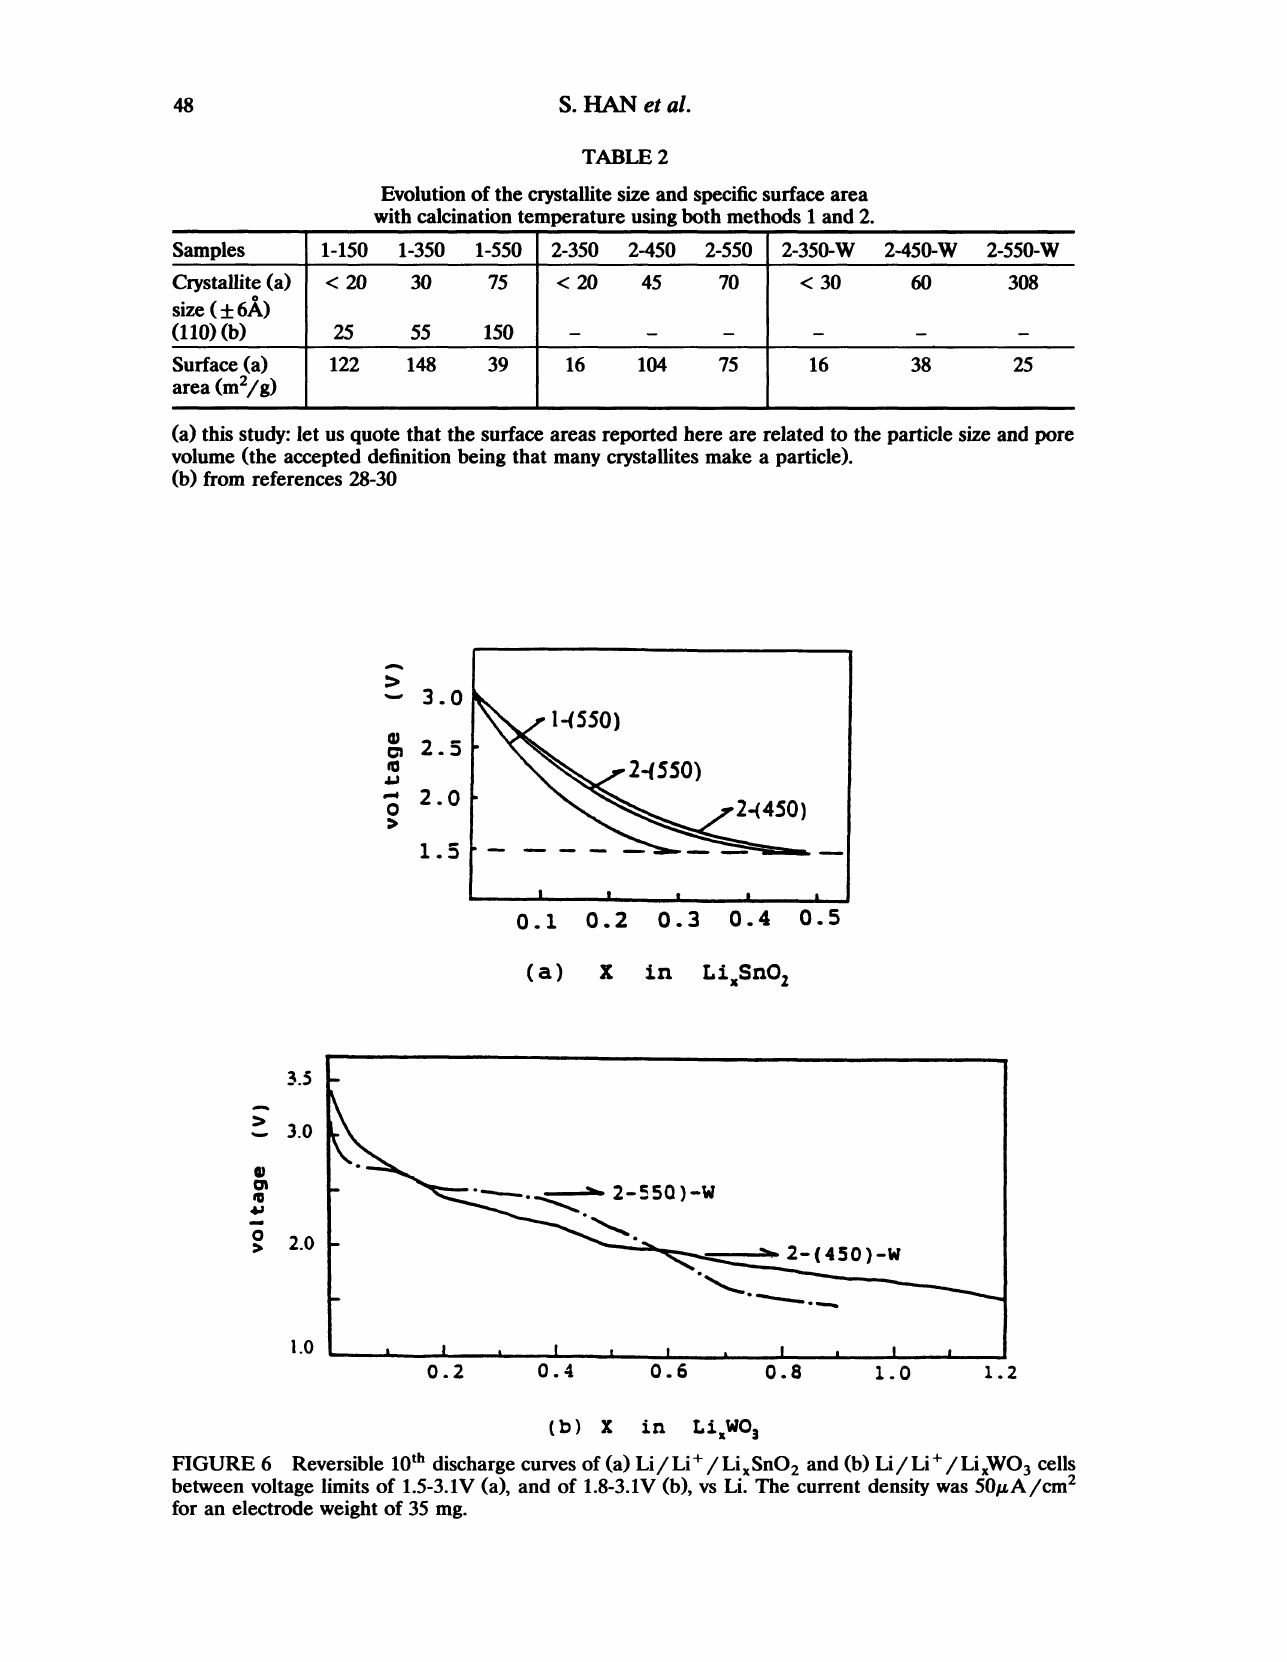
and (b) Li/Li +/LixWO cells 2